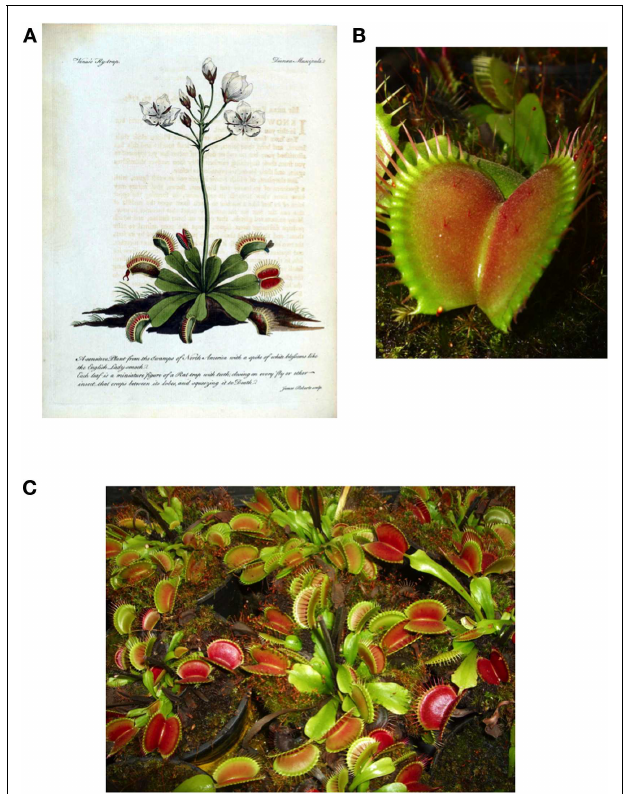
FIGURE 1 | Picture and illustration of Dionaea muscipula Solander ex Ellis . (A) First drawing ofVenus flytrap from the first botanical description made by John Ellis and send to Carl von Linné around 1770. (B) Picture of Dionaea muscipula trap, sensitive hairs are located on the inner face of the trap. (C) Picture of D. muscipula cultivated by the first author in his own greenhouse.